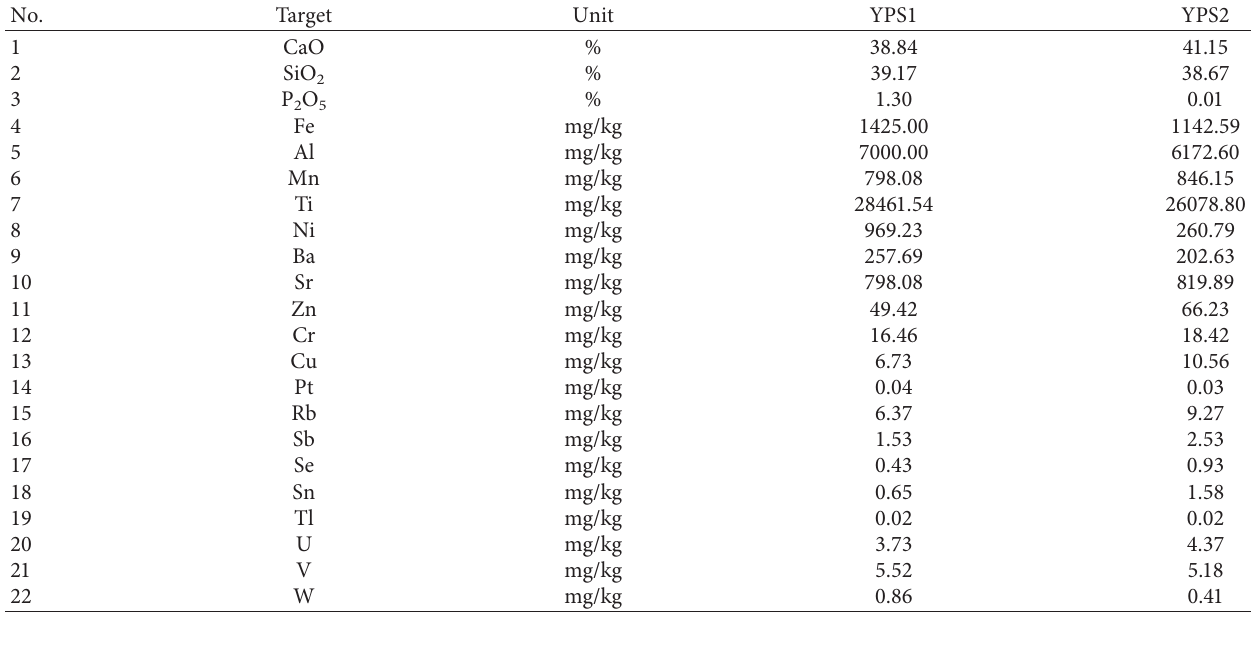
Table 2: Composition of YPS samples obtained from the ICP method.